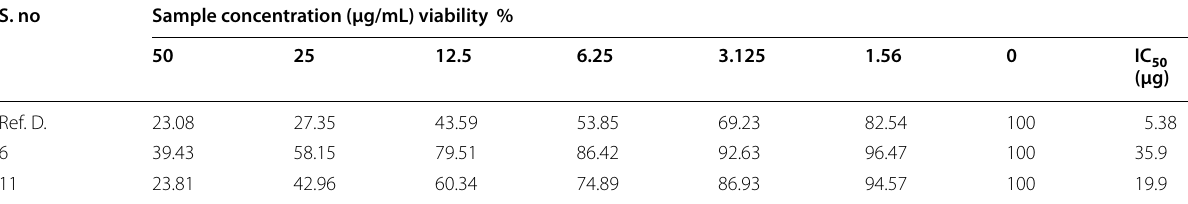
of thiophenes 6 and 11 against HCT-116 Cell Line 50